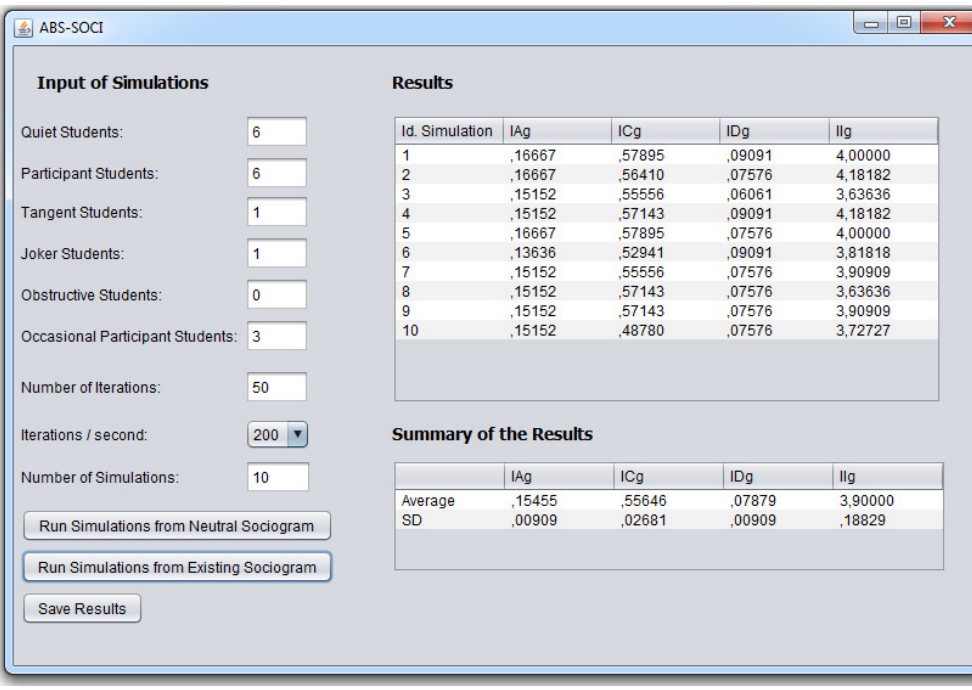
Figure 2. Main frame of the user interface (UI) of the Agent-Based Simulator of Student Sociograms